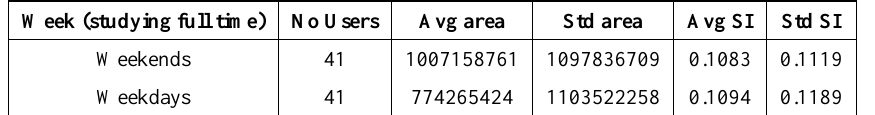
Table 16. Average and standard deviation of area and shape index of full time studying users grouped based on weekdays.